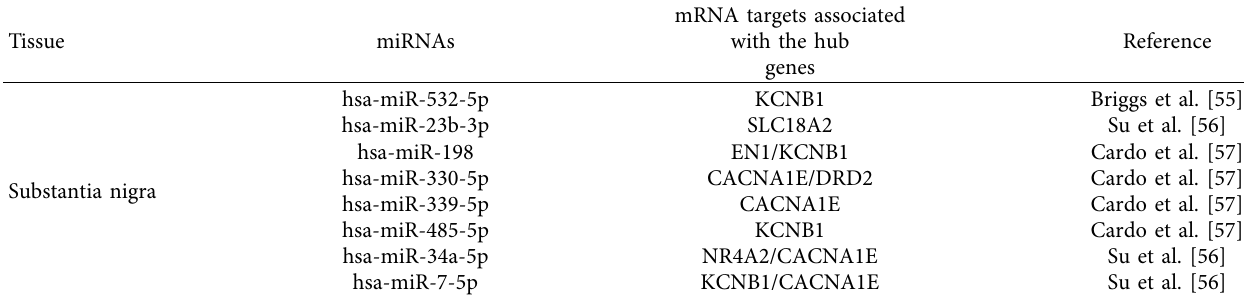
Figure 6: Te box plots of the expressions of 15 hub genes in SN of patients with PD and control samples. ∗∗∗ Te expression levels of hub genes in SN tissues of PD samples were signifcantly decreased compared with those in control samples ( P value < 0.01 and logFC ≤ − 1.0). ∗∗ Te gene expression level was reduced in SN tissues of PD samples, but not signifcantly ( P value < 0.05 and − 1 < logFC < 0). ns: the gene expression level was decreased in SN tissues of PD samples, but it was not statistically signifcant ( P value > 0.05). Table 6: Te details of eight target